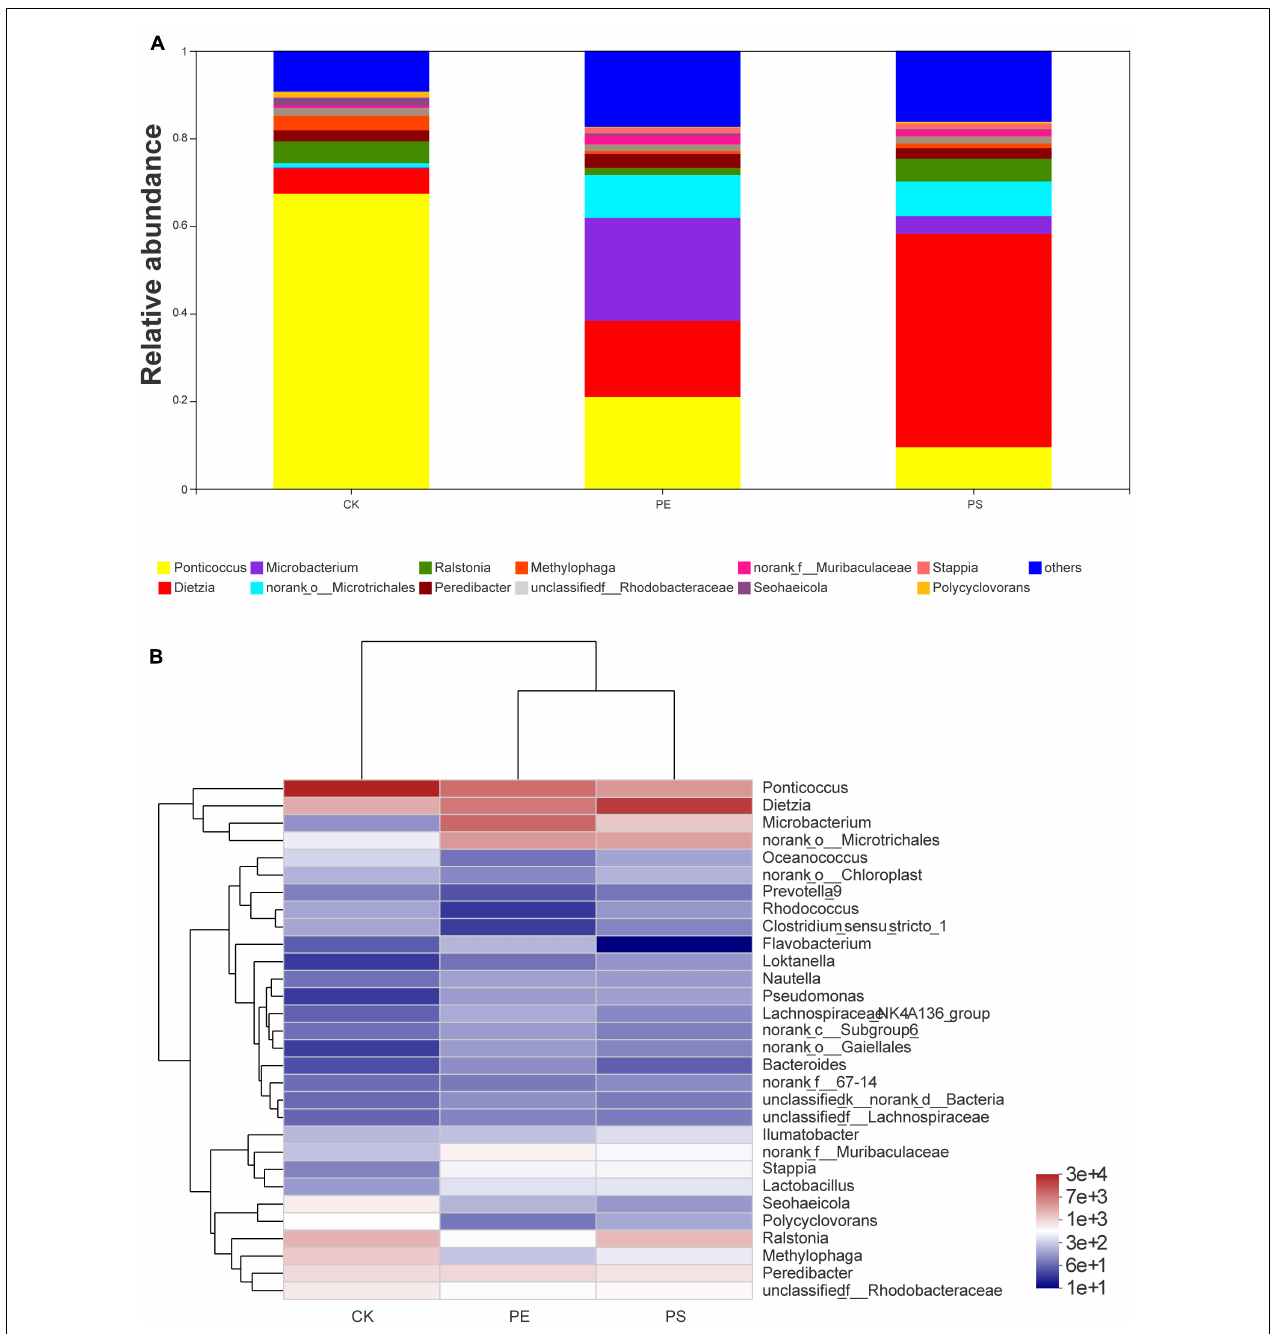
FIGURE 8 | Relative abundance of intestinal microbiota at the genus level: (A) bar plot and (B) heat map